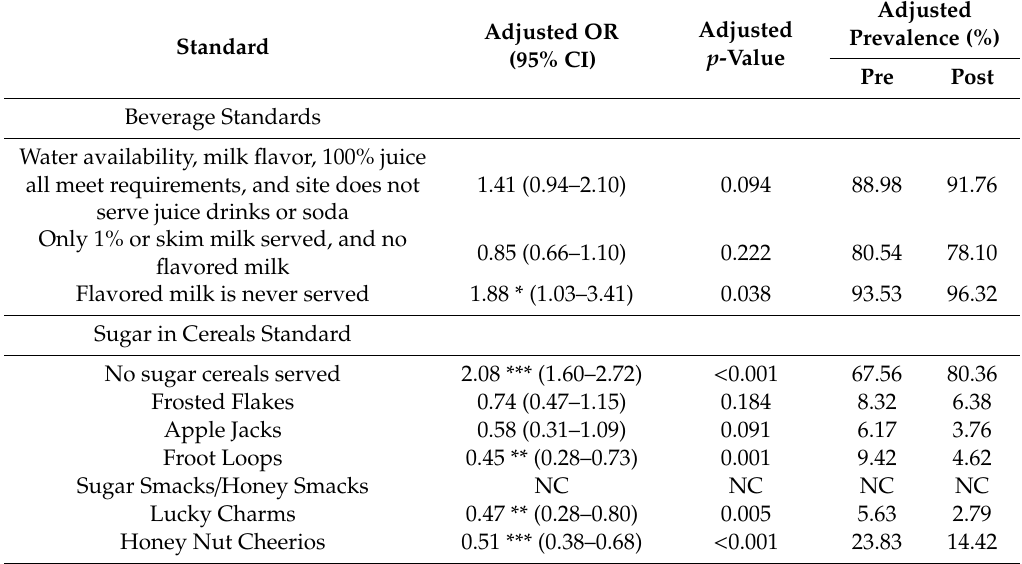
Table 2. Progress in meeting selected CACFP standards (adjusted models),